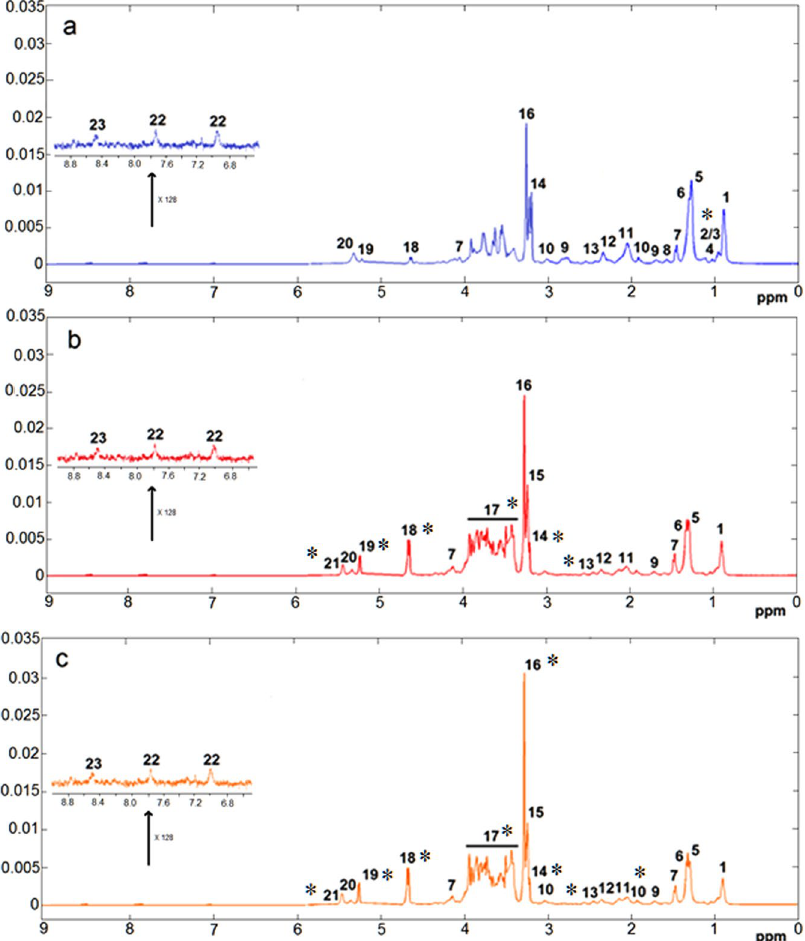
Figure 1. Average spectra of liver from 1 H HRMAS CPMG experiment. ( a ) Control group, ( b ) HFS group, and ( c ) HFS + C group. Assignments: 1, lipids; 2, isoleucine; 3, leucine; 4, valine; 5, lipids; 6, lactate; 7, alanine; 8, lipids; 9, lysine; 10, acetate; 11, glycoproteins (acetyl); 12, glutamine; 13, glutamate; 14, choline; 15, phosphocholine/glycerophosphocholine (PC/GPC); 16, betaine; 17, alpha-glucose and beta-glucose/glycogen; 18, beta-glucose; 19, alpha-glucose; 20, lipids; 21, glycogen; 22, histidine; 23, ATP/ADP/AMP. * Denotes the main changes.